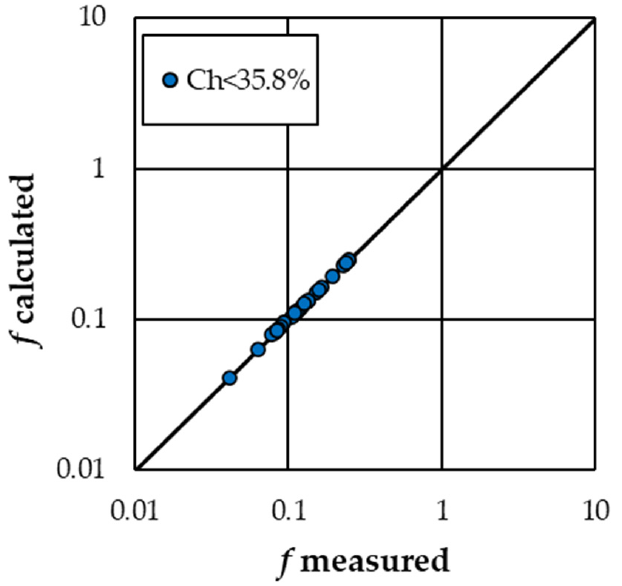
Figure 6. Comparison between the measured f values and those calculated by Equation (13) for the “Longitudinal stripe” arrangement.